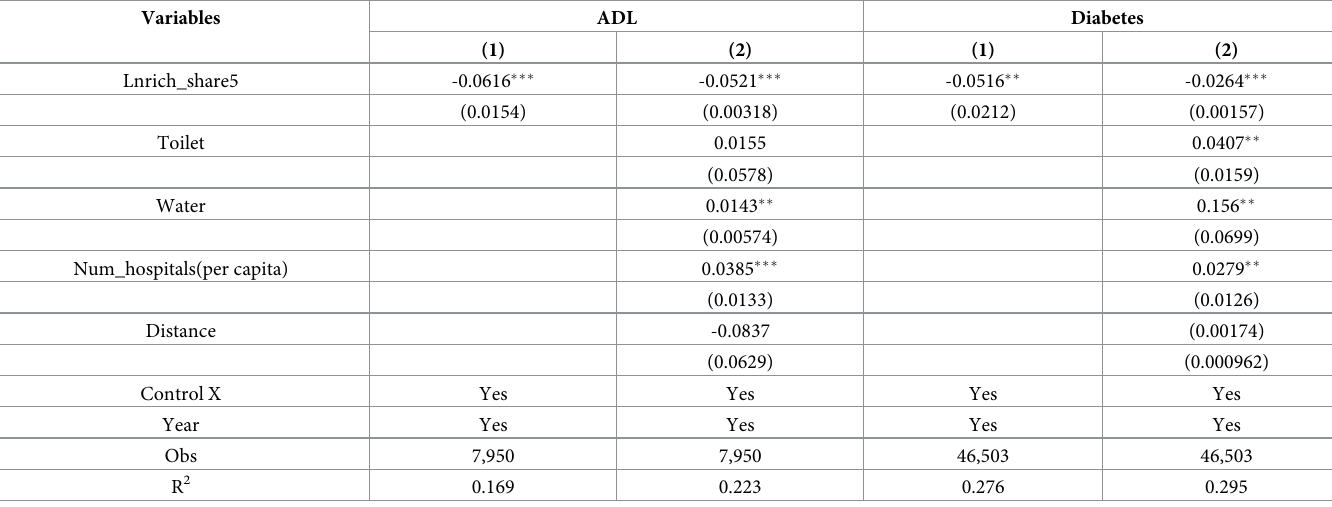
Table 8. Possible channels of influence of income